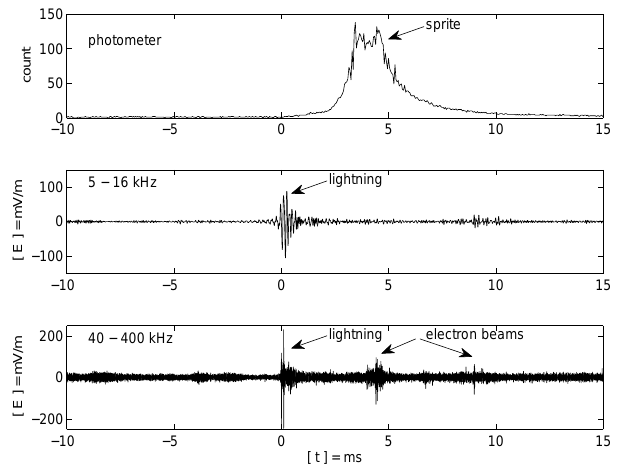
Fig. 3. The sprite luminosity occurs ∼ 3–6ms after the causative positive lightning discharge at 0ms (upper panel) as observed from Pic du Midi with a high-speed photometer. The lightning discharge emits a burst of electromagnetic radiation in the frequency range from ∼ 5–16kHz (middle panel) which is recorded with a wideband digital radio receiver in South-West England (51.3 ◦ N, 2.3 ◦ W). Two consecutive bursts of electro- magnetic radiation in the frequency range ∼ 40–400kHz occur at ∼ 4.4ms and ∼ 8.9ms (bottom panel). These bursts are thought to be caused by relativistic electron beams above the thundercloud.